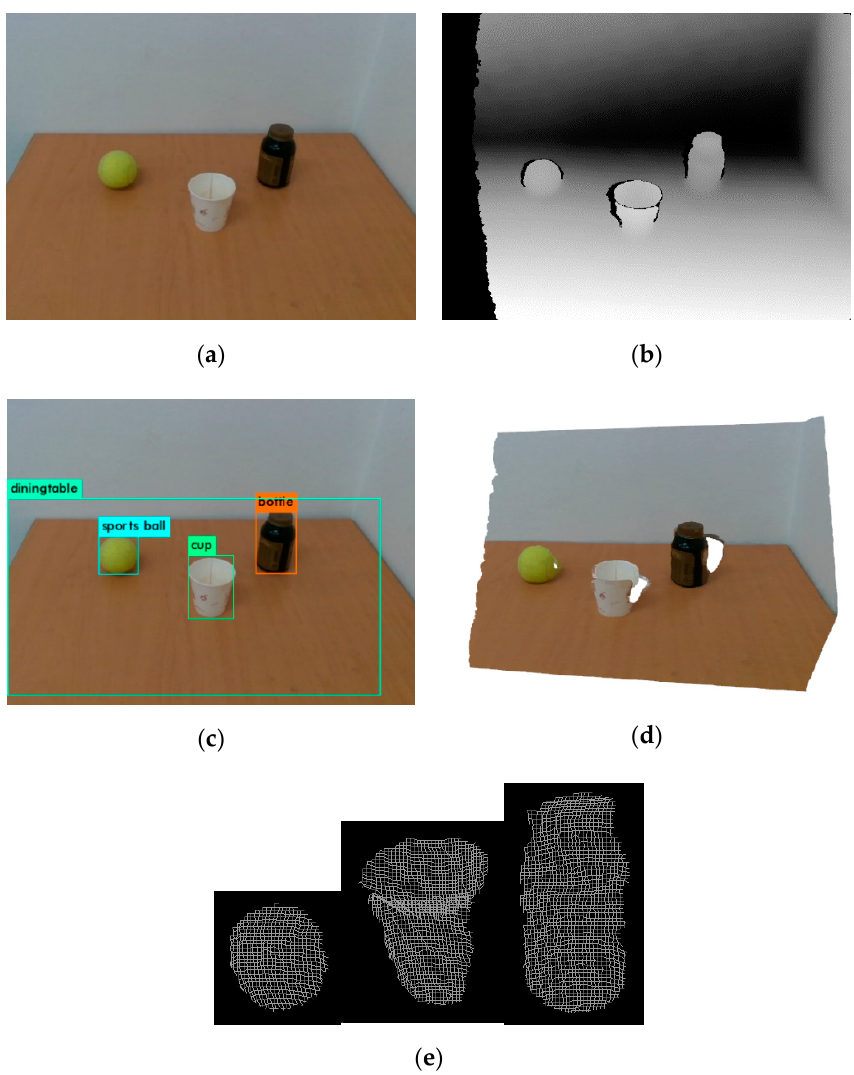
Figure 8. The result of object recognition with the fog robot service: ( a ) an RGB image; ( b ) a depth image; ( c ) the result of object recognition with bounding boxes (BBXs) and labels; ( d ) a 3D view of the scene; ( e ) the result of 3D object recognition after 3D segmentation on the BBX areas.